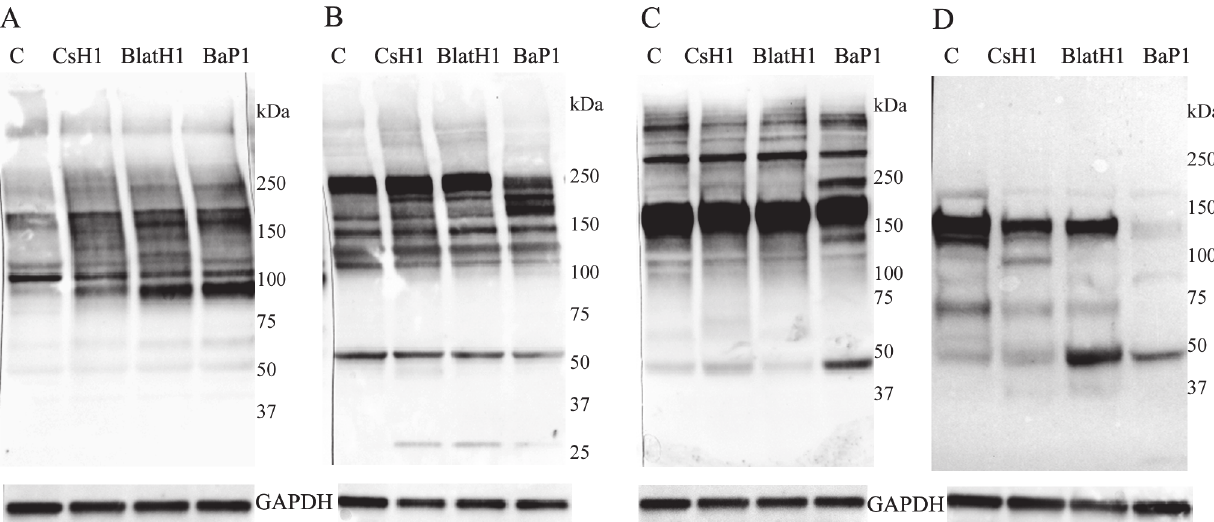
Fig 3. Western blot analysis of basement membrane components in skin homogenates. Groups of five mice were injected by intradermal route in the ventral abdominal region with either BaP1 (PI, 75 μ g), BlatH1 (PII, 1.5 μ g), CsH1 (PIII, 35 μ g) SVMPs or PBS (lane C). After 15 min, mice were sacrificed, their skin was removed, and an area of 12 mm diameter was dissected out. Tissues of the same group were homogenized and centrifuged, and the supernatant collected. Then, 10 – 20 μ L of each skin homogenate sample were separated under reducing conditions on 4 – 15% Tris – HCl SDS-PAGE gradient gels, and transferred to nitrocellulose membranes. Immunodetection was performed with (A) anti-collagen type IV, (B) anti-collagen type VI, (C) anti-laminin, and (D) anti-nidogen 1. The anti-GAPDH antibody was used as loading control. The reaction was detected using an anti-rabbit peroxidase antibody and a chemiluminescent substrate. Images were obtained with the ChemiDoc XRS+ System (BioRad).